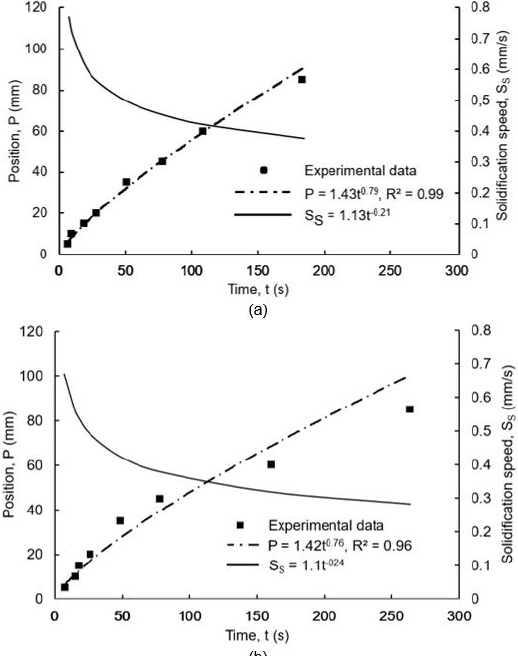
) S Figure 9. Cooling rate ( )  T versus position ( P